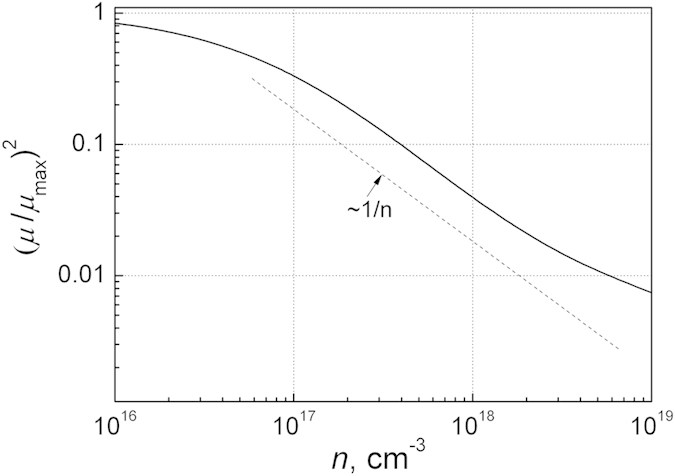
Relation between mobility and free electron density for silicon (according to data2739).